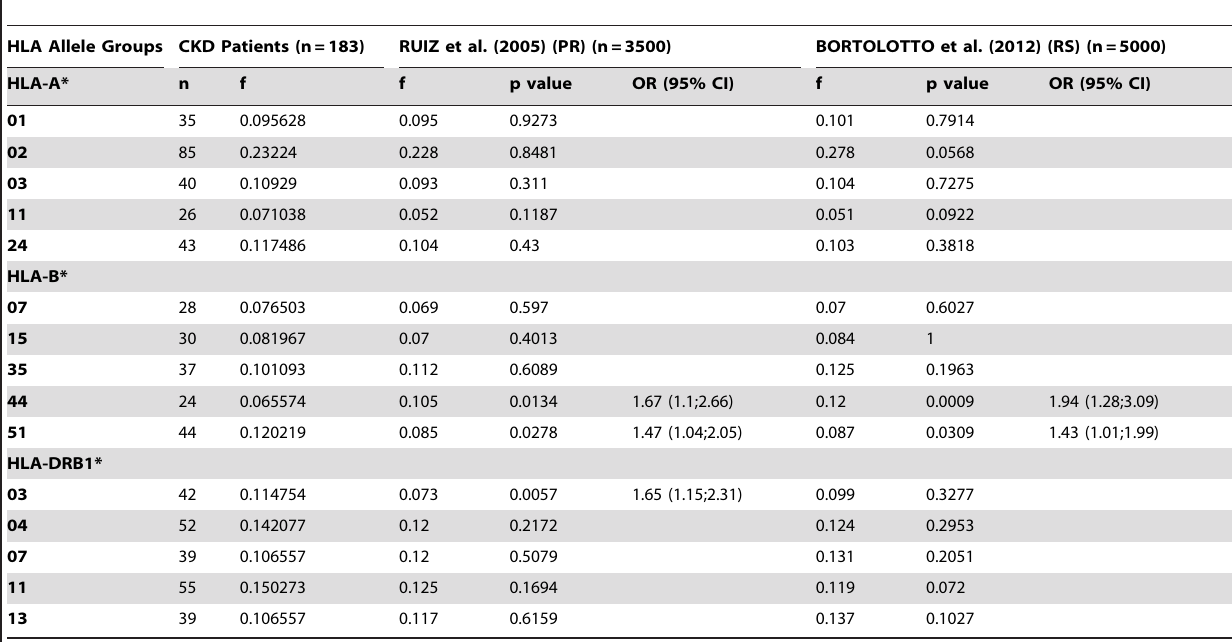
Table 4. Distributions of the most frequent HLA allele groups in CKD patients in southern Brazil, compared to healthy subjects in other studies [ 9,12 ]